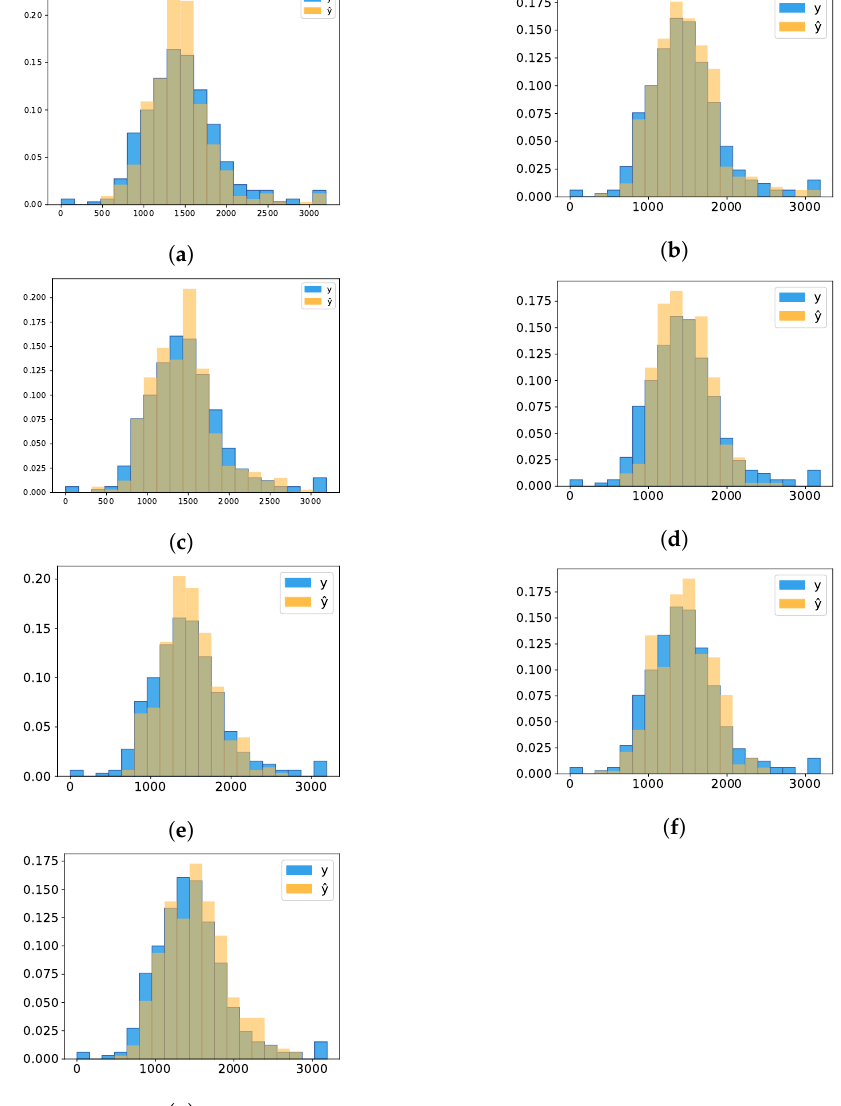
Figure 6. Comparison of predicted ˆ y vs. real y in relation to LDMY data distribution. ( a ) AlexNet; ( b ) AlexNet pretrained; ( c ) MaCNN; ( d ) LF-CNN; ( e ) ResNeXt50; ( f ) ResNeXt50 pretrained; ( g )